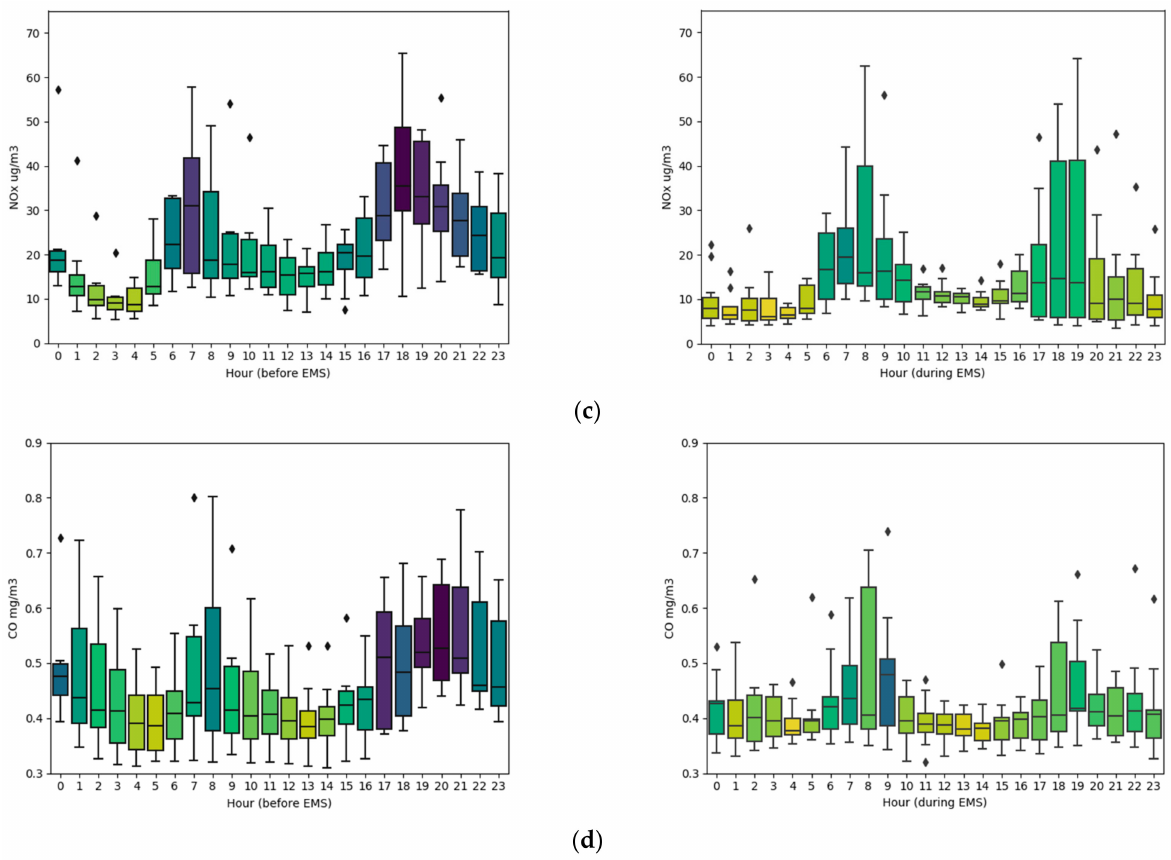
Figure A5. Liman SEPA, NN2, station, hourly boxplots before ( left ) and during emergency state ( right ) ( a ) SO 2 ( b ) O 3 ( c ) NO x ( d )